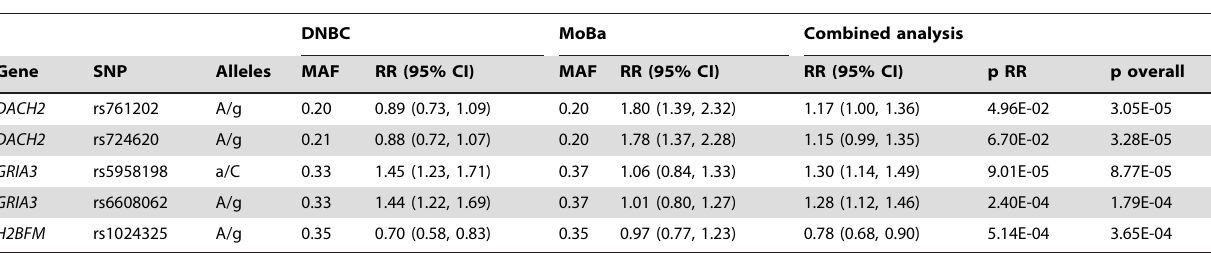
Table 6. Sex-stratified analysis, females.